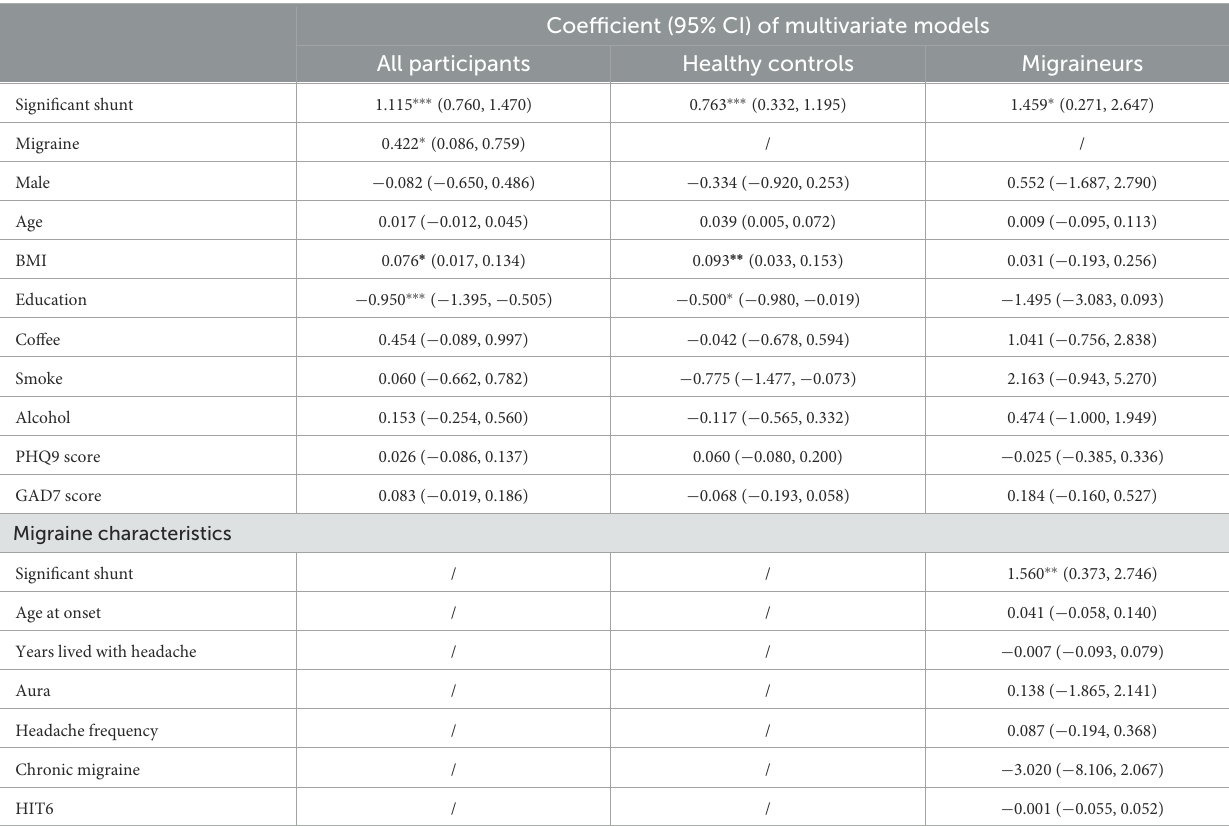
TABLE 3 Multivariate linear regression models of photosensitivity scores in healthy controls and migraineurs. Coefficient (95% CI) of multivariate